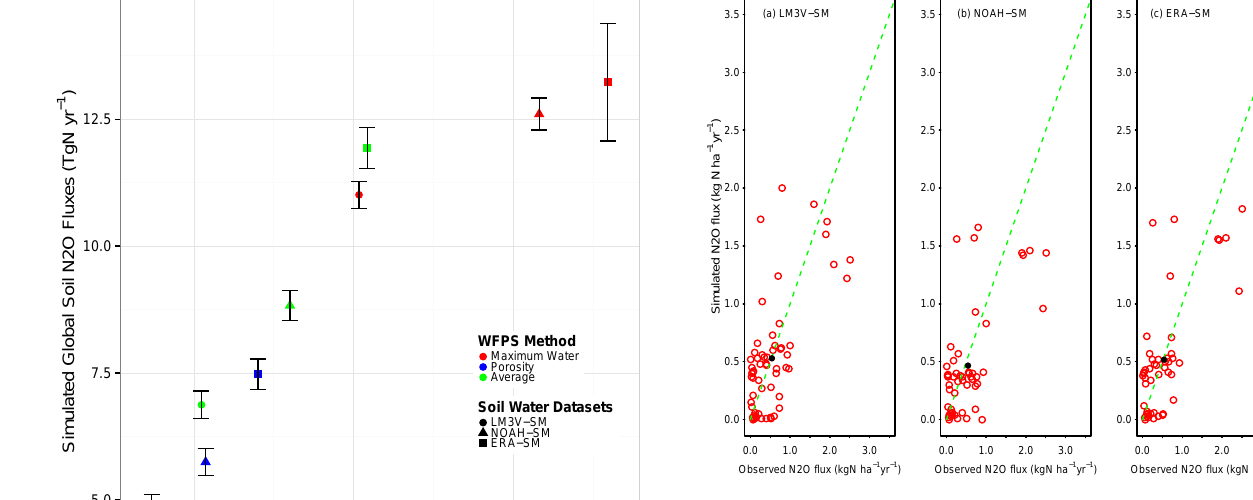
Figure 4. Observed vs. simulated annual N 2 O emissions from nat- ural soils. Dashed green lines are the 1 : 1 lines. The solid cir- cles represent the overall means. Different panels represent sim- ulations with different soil moisture data: (a) LM3V-SM (simu- lated by LM3V-N); (b) NOAH-SM (based on land surface model NOAH 3.3 in Global Land Data Assimilation System Version 2); and (c) ERA-SM (reanalysis data from ECMWF). Water-filled pore space (WFPS) is calculated using the average of the one based on available water capacity and the one based on the total porosity (Method 3, see the main text for detailed description) for panel (a) ; and using the total porosity (Method 2) for panel (b) and (c)